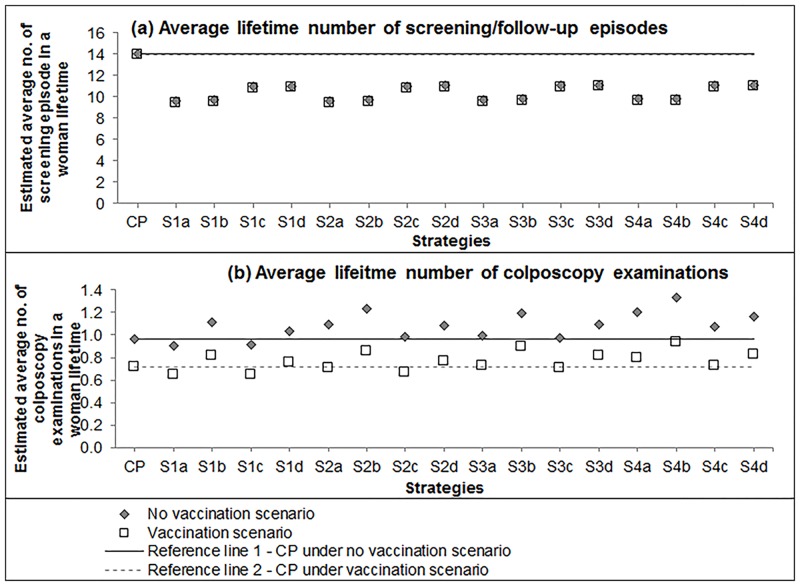
Model predicted average lifetime number of (a) screening/follow-up episodes and (b) number of colposcopies examinations.